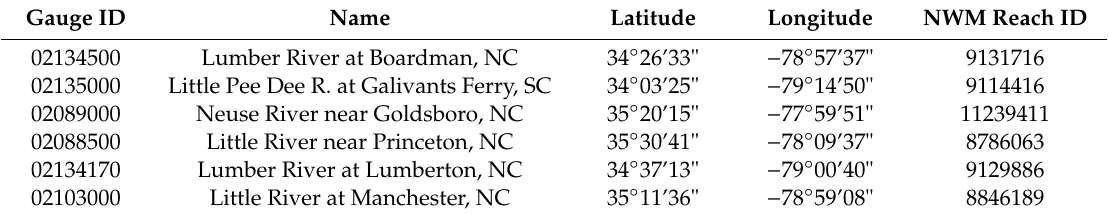
Table 1. Locations of the selected United States Geological Survey (USGS) stream gauges and their intersected National Water Model (NWM)